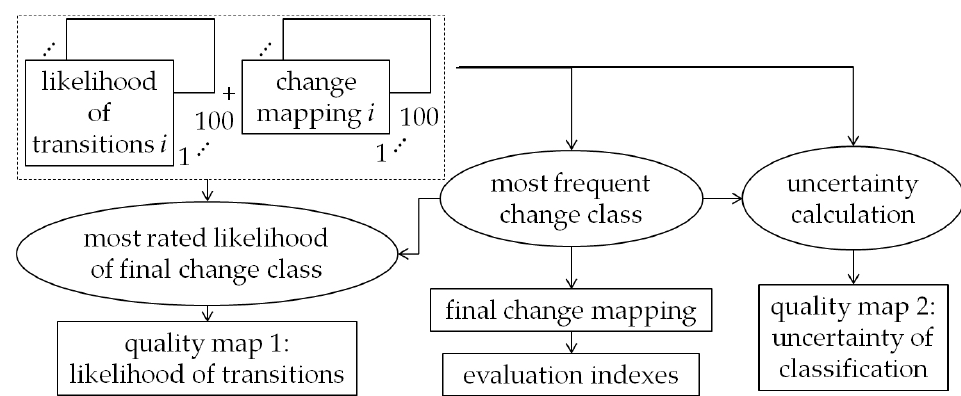
Figure 10. Final change mapping determination and quality mappings